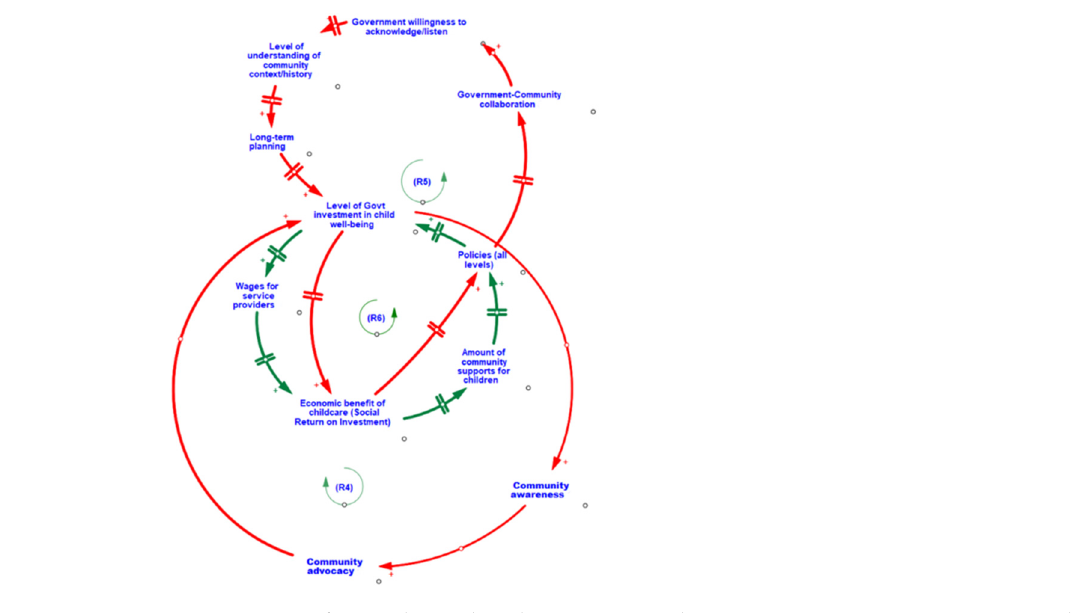
Figure 3. CLD of interrelationships between societal returns on investment, community advocacy, and level of government investment in child well-being.